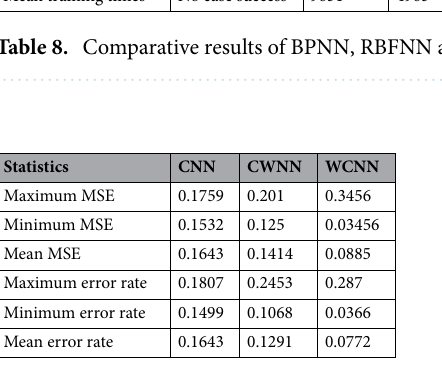
Table 9. Comparative results of CNN, CWNN and WCNN on MNIST